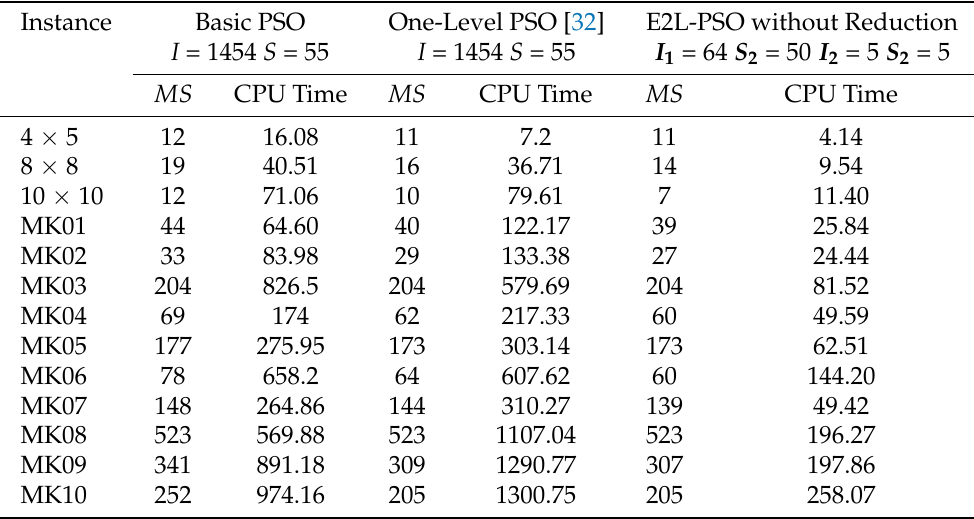
Table 6. Comparison 2 between the three developed PSO variants on Raspberry Pi